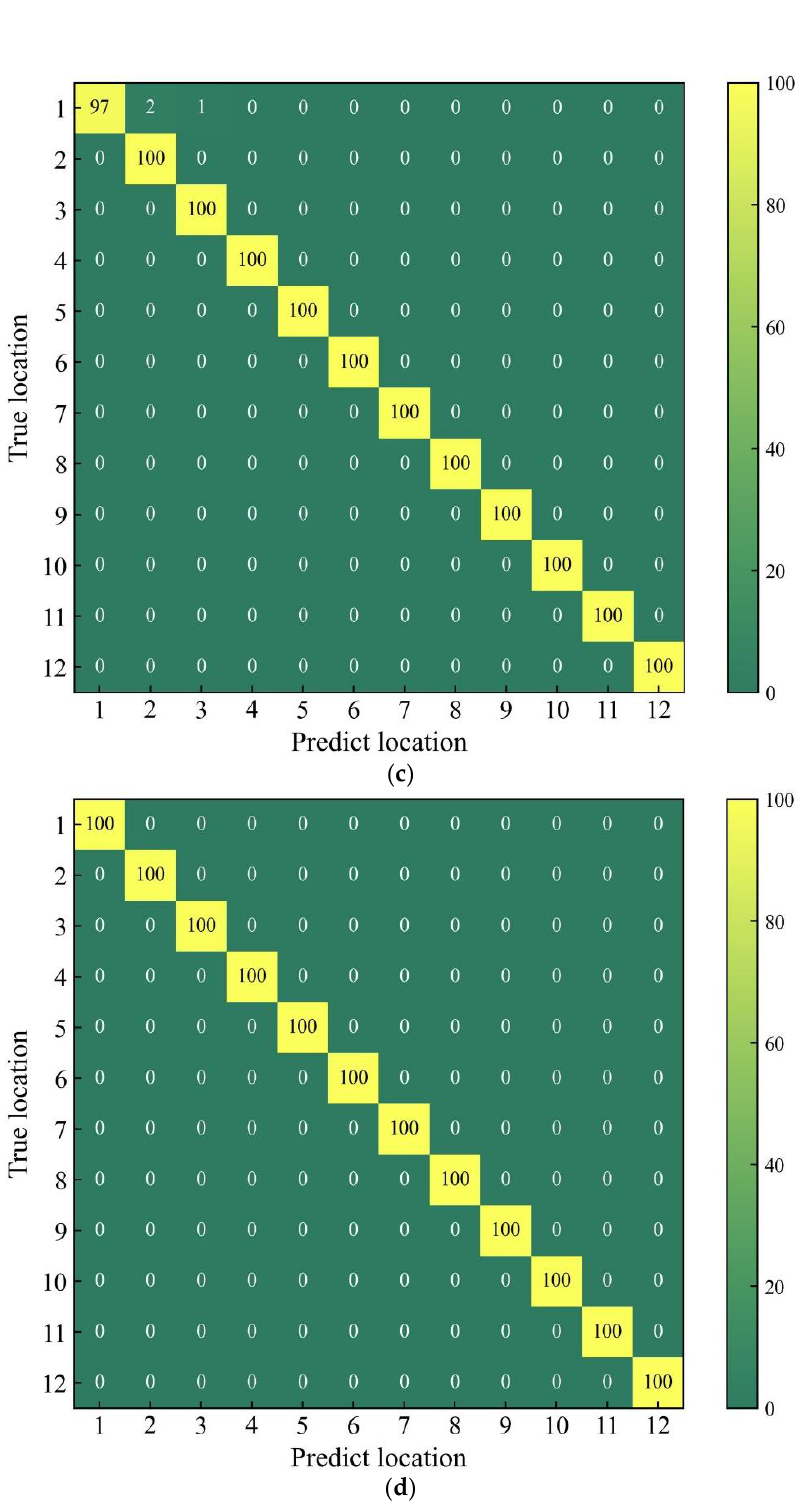
Figure 9. Confusion matrices of the CNN, GRU, CNN-GRU, and proposed PCG model for SCR damage location identification. ( a ) Damage location results of CNN, ( b ) Damage location results of GRU, ( c ) Damage location results of CNN-GRU and ( d ) Damage location results of PCG.